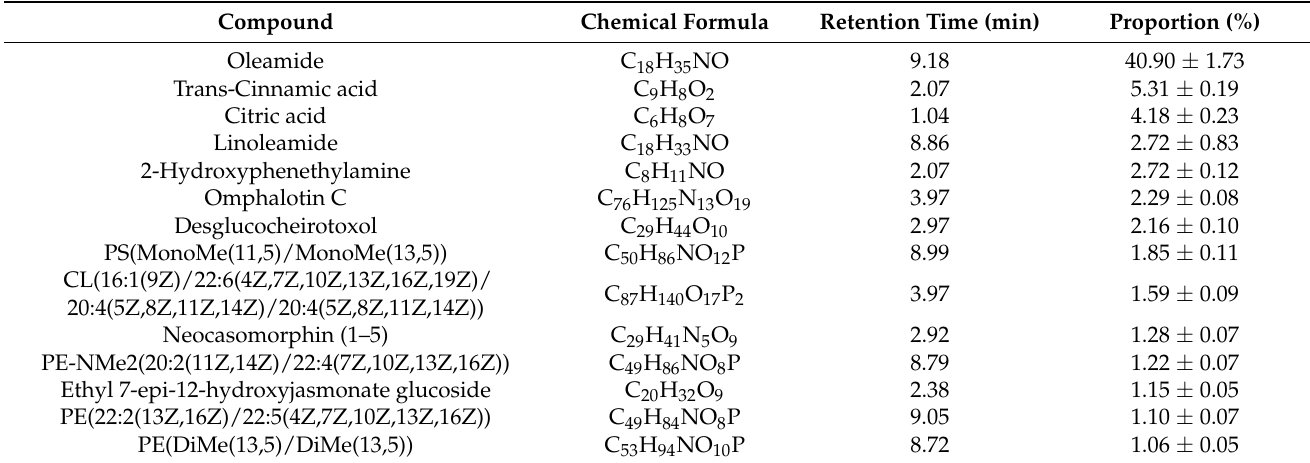
Table 1. The chemical composition of metabolites produced by the Lactiplantibacillus plantarum LPP703 strain.